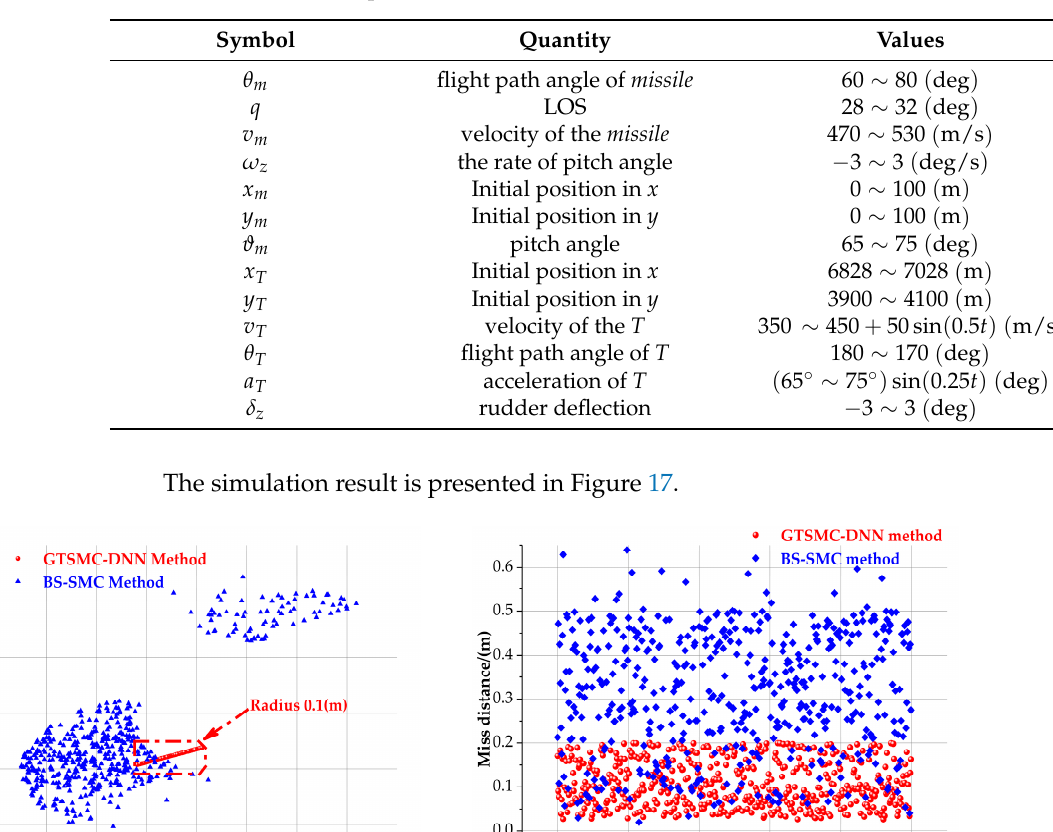
Figure 16. ( a ) System states of δ z angle; ( b ) System states of w z angle.